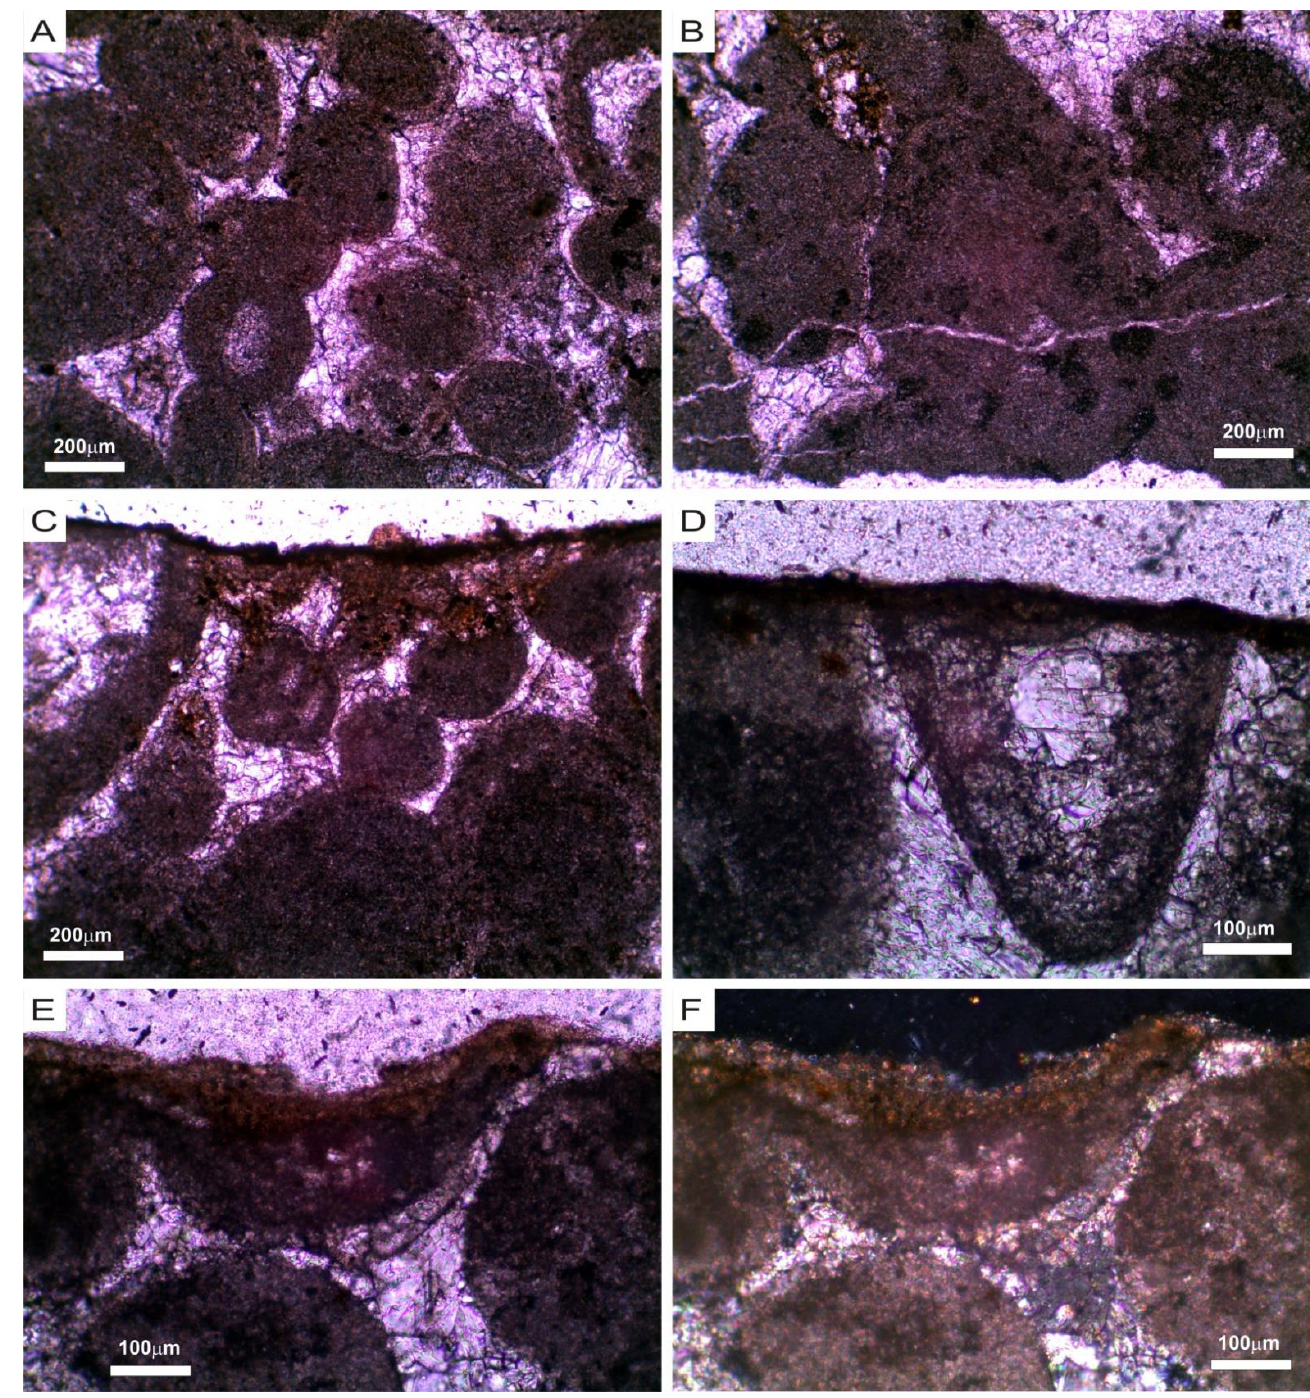
Figure 4. Optical photomicrographs. ( A ) Interparticle and intraparticle calcite cements between grains with point, long and concave–convex contacts. ( B ) Detail of a fracture filled by microcrystalline calcitic cement. ( C ) General view of the surface alteration crust. ( D – F ) Detail of the surface alteration crusts (see text). ( A – E ) plane polarized light; ( F ) cross polarized light.